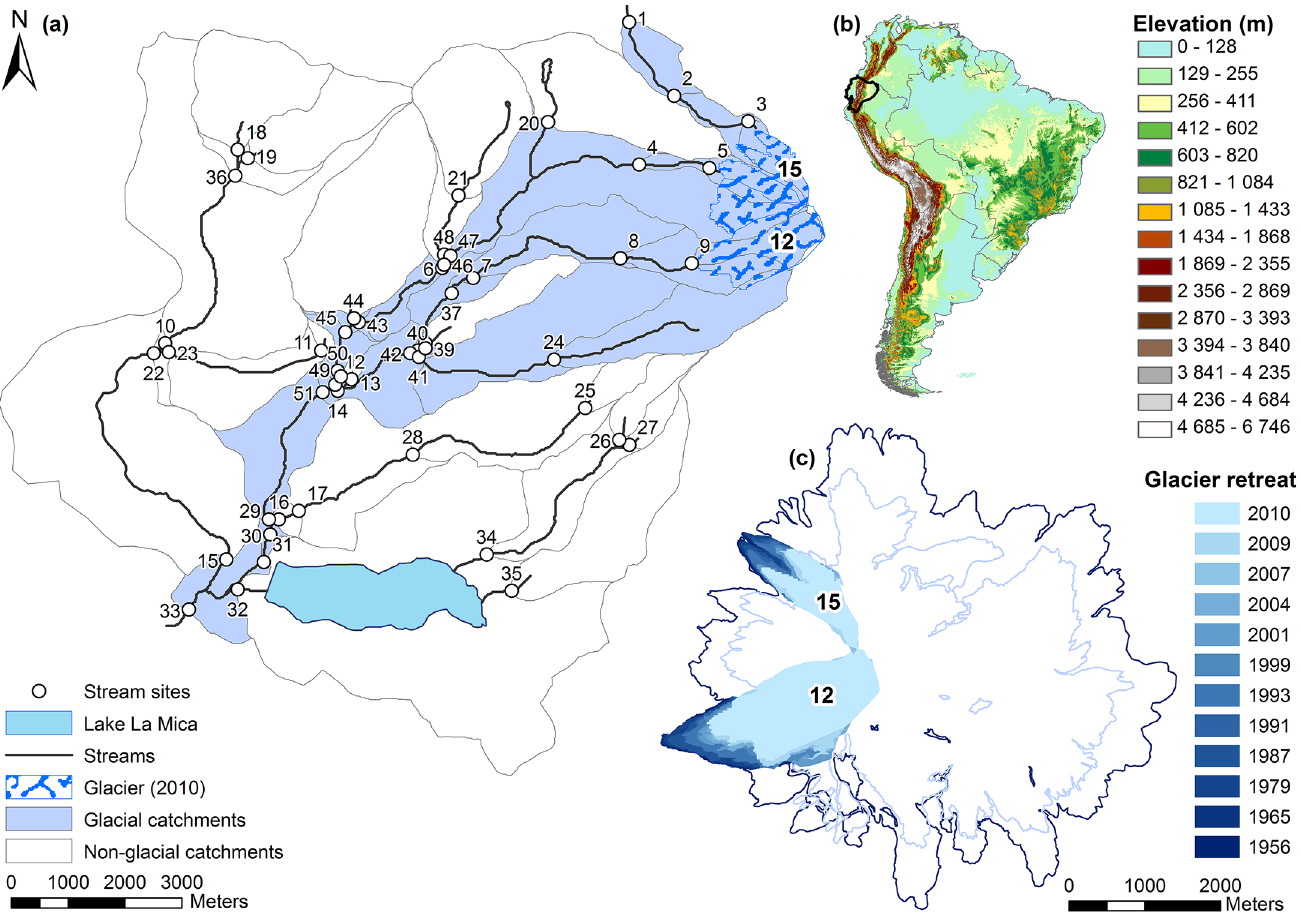
Fig 1. Study area: The Antisana Volcano (Ecuador). (a) Map of the study area at the Antisana volcano. Study sites are represented by open circles. Catchment basins of all sites are represented by polygons; light blue polygons for glacial catchments and white for non-glacial catchments. The catchments were delimited based on a 40m resolution DEM using SAGA GIS (2.0.8). The glacier outlines were computed based on Landsat satellite images from 2010 (see [35] for glacier outlines and catchment delimitation details). (b) Elevation map of South America. South America countries were delimited in grey, with Ecuador highlighted in black. The 30 arc-second digital elevation model was taken from http://www.arcgis.com/features/. (c) Map of the retreat of Antisana ’ s glaciers since 1956. Total glacier outlines were represented for the years 1956 and 2009. Outlines of glaciers “ 12 ” and “ 15 ” were represented for 12 years between 1956 and 2010. Glacier outlines were computed from Landsat satellite images. Maps were made using ArcGis (10.0).